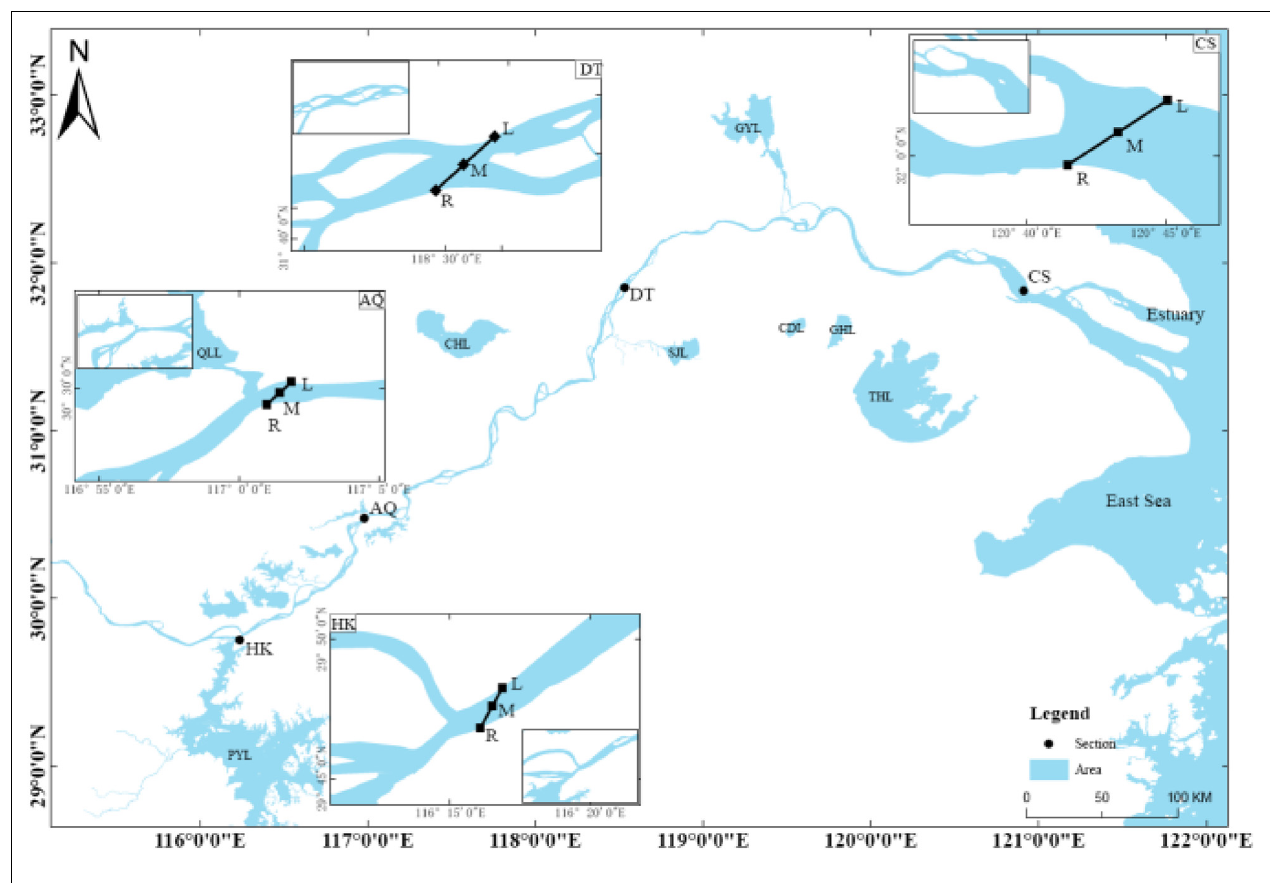
FIGURE 1 | Sampling site details in the Yangtze